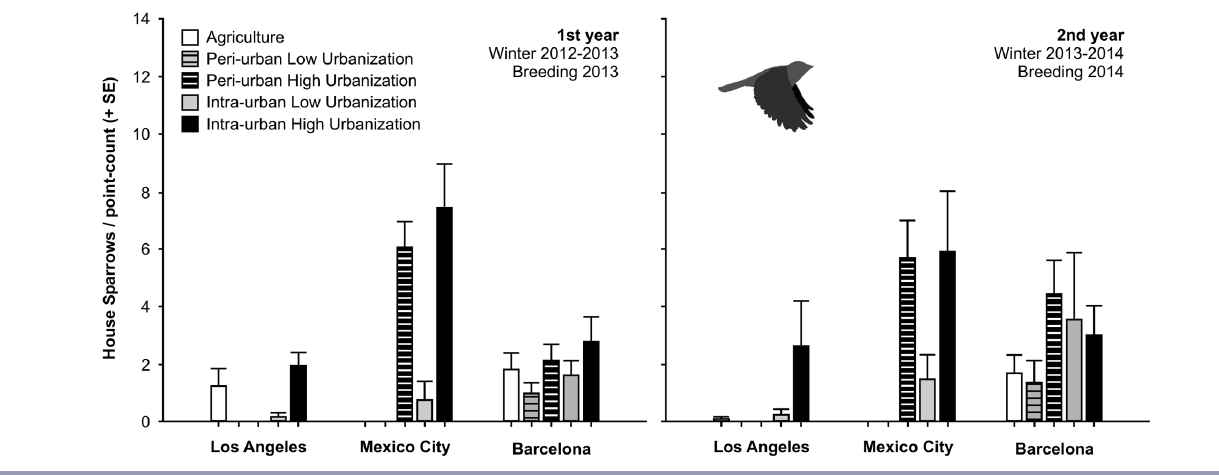
Fig. 3 . House Sparrow ( Passer domesticus ) abundances per point-count recorded in the three surveyed urban- agricultural landscapes.